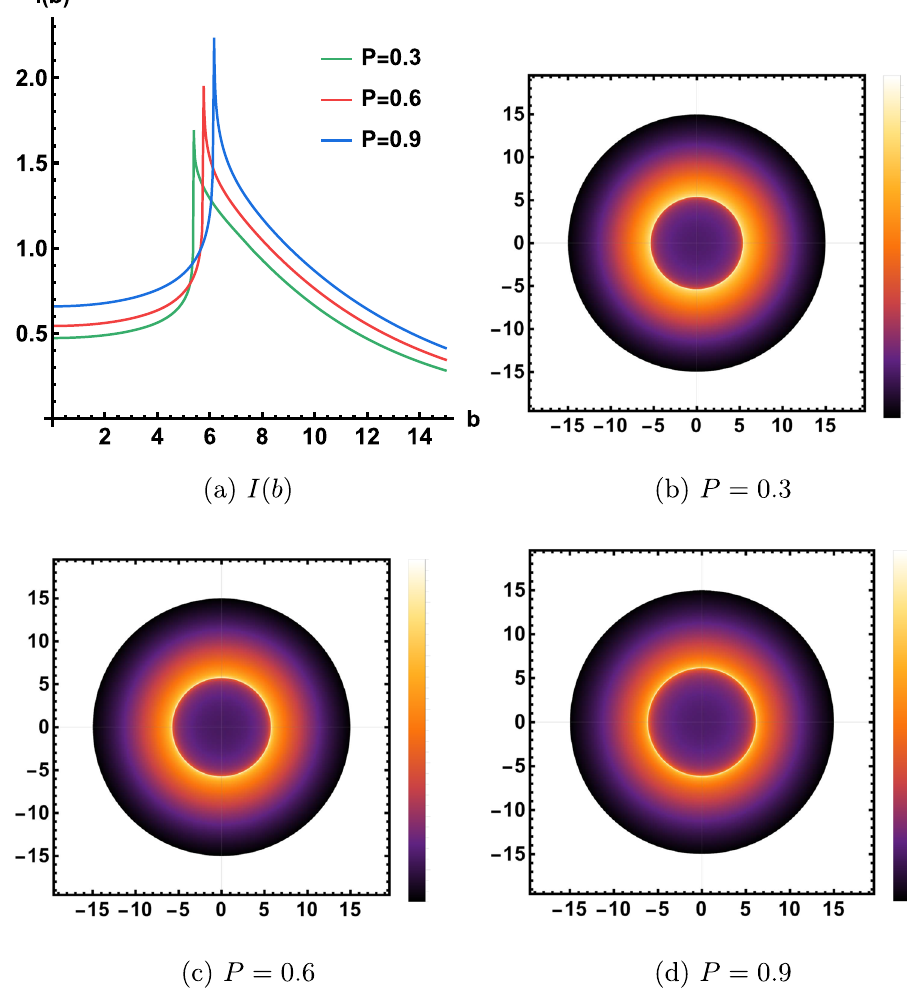
Fig. 7 The specific intensity I with respect to different impact parameters b in the top-left panel. And the other figures are the BH shadows with static accretions for different magnetic charge with β = 0 . 1 and M =